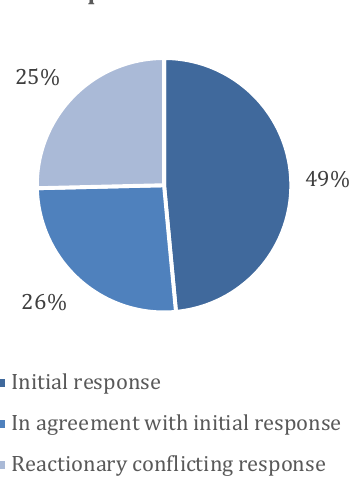
The overall number of comments indicates that ‘ethnic’ and ‘inter-ethnic’ themes attract attention, spark dynamic public debate, and suggest that personal ‘ethnicity related’ experiences are not uncommon. The content of the comments also indicates that inter-ethnic conflicts which happened over 25 years ago remain alive in contemporary discourse, shaping current attitudes and prejudices. Attitude towards victims: From empathy to hate speech